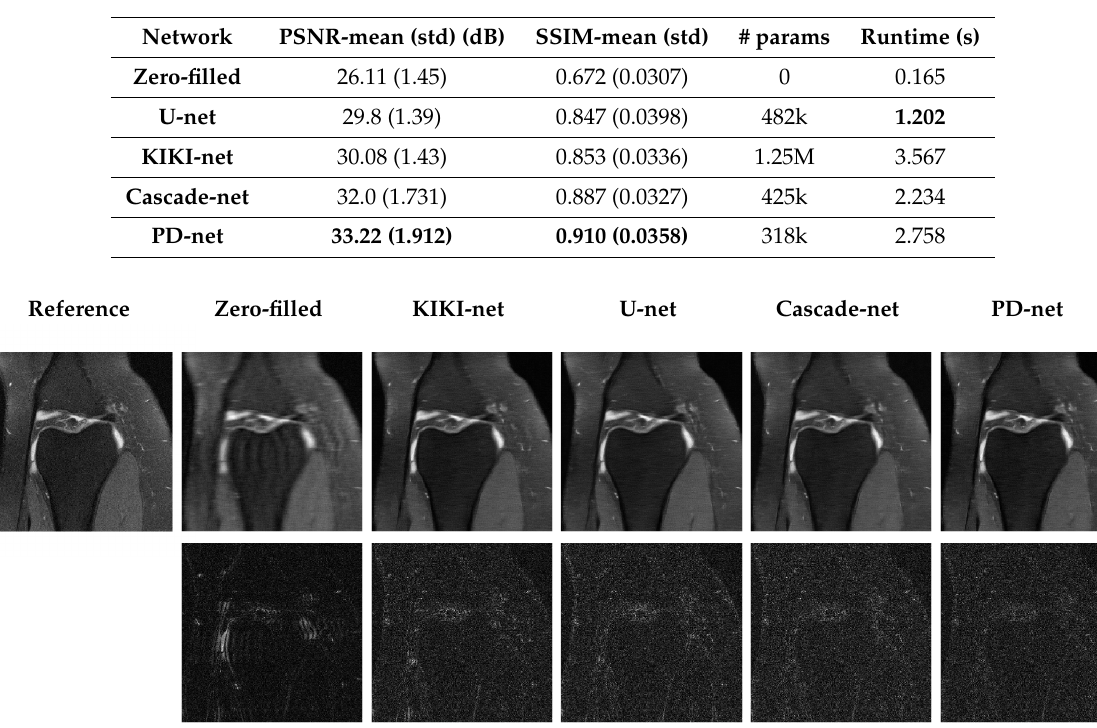
Table 4. Quantitative results for the OASIS dataset. PSNR and SSIM mean and standard deviations are computed over the 200 validation volumes. Runtimes are given for the reconstruction of a volume with 32 slices.